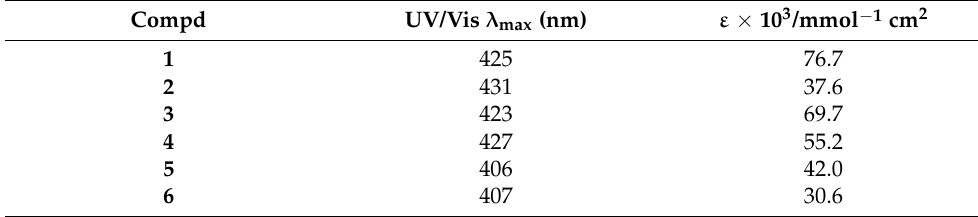
Table 1. Electronic absorption data of 1–6 compounds (sodium cacodylate buffer, I = 0.05 mol dm − 3 , pH =